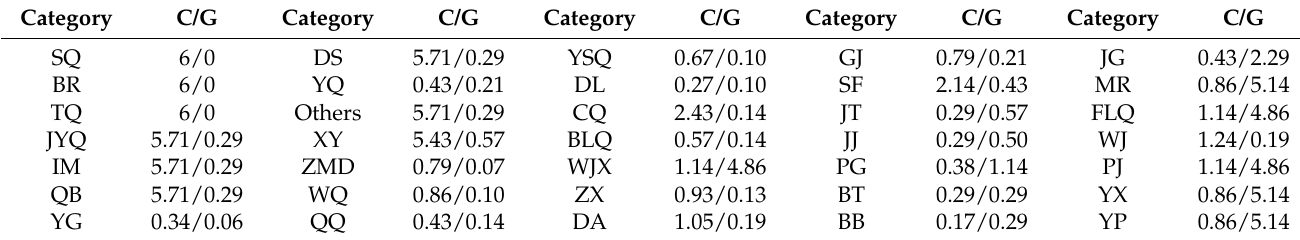
Table 2. Measurement statistics on the continuity and intermittentness of cultural relics of different categories.